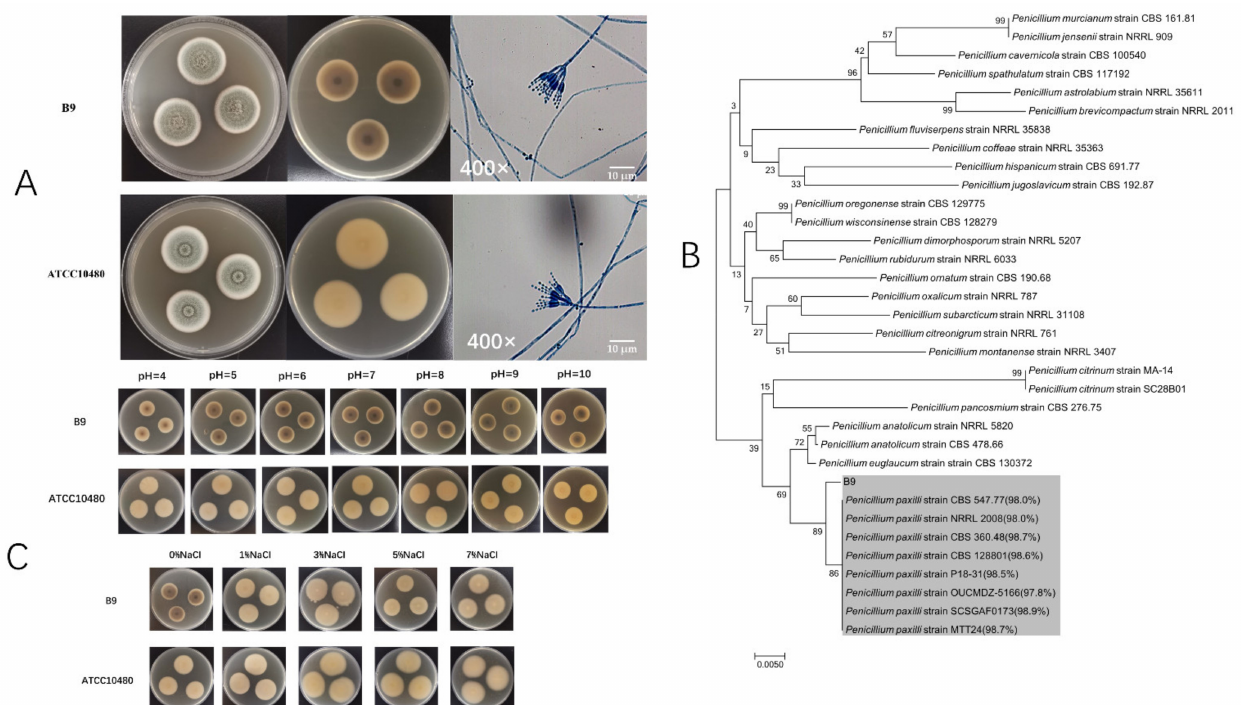
Figure 1. Analysis of species of the B9 strain. ( A ) Colony morphologies of Strain B9 and ATCC 10480 on MEA at 28 ◦ C after 5 days. From left to right: obverse colonies on MEA, reverse on MEA, and observation results under an optical microscope of 400 × magnification (scale bar 10 µ m). ( B ) Phylogenetic tree of strain B9 based on the ITS sequence; the evolutionary history was inferred using the neighbor-joining method. Phylogenetic analyses were conducted with 1,000 bootstrap replications in MEGA7. Numbers above branches indicate bootstrap values. ( C ) Comparison of the physiological characteristics between B9 and P. paxilli ATCC 10480 under different pH values (upper) or salinities